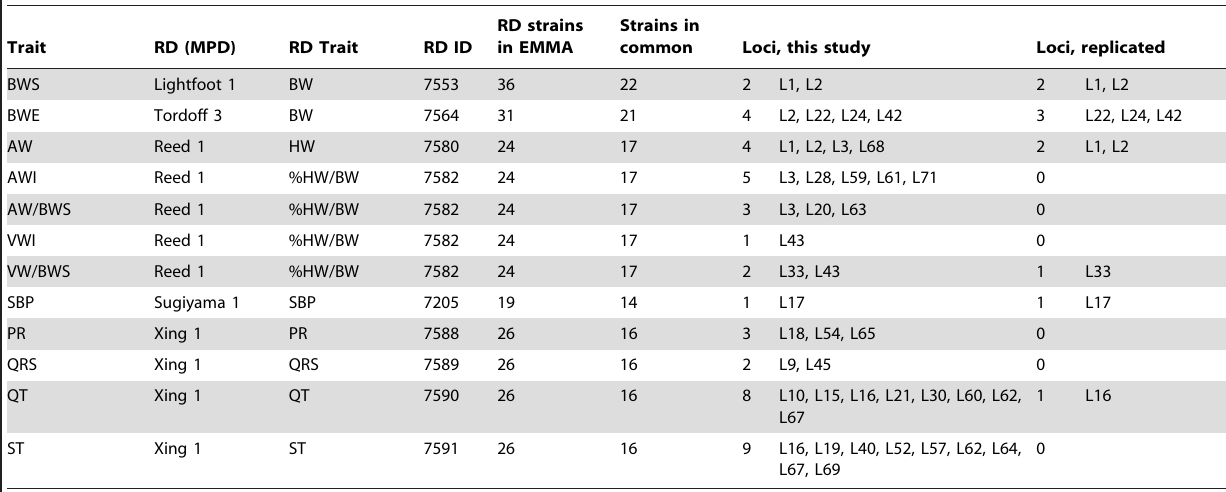
Table 3. Replication